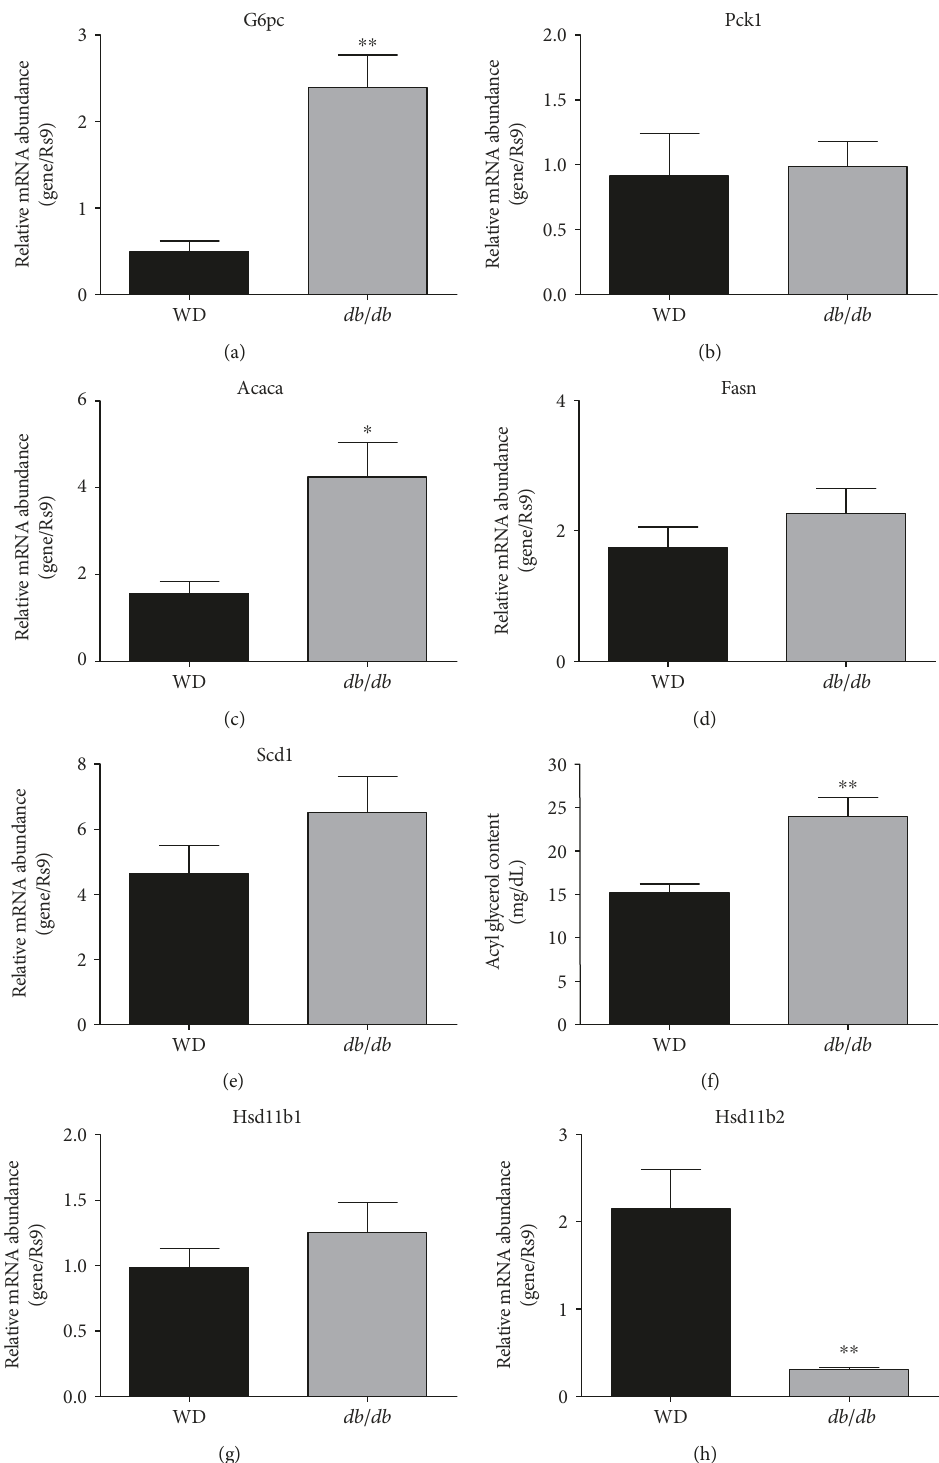
Figure 6: Livers from db/db mice displayed enhanced expression of glucose 6-phosphatase, acetyl Co-A carboxylase, and elevated acyl glycerol content when compared with livers from WD-fed mice. Relative mRNA abundance of the G6pc (a), Pck1 (b), Acaca (c), Fasn (d), Scd1 (e), Hsd11b1 (g), and Hsd11b2 (h) genes in the liver tissue from either C57BL/6J mice fed either Western diet for 20 weeks (black panels) or 14-week-old db/db mice (gray panels). Acyl glycerol content (f) was quanti fi ed using 30mg of liver tissue from either Western diet-fed C57BL/6J mice (20 weeks on diet; black panels) or 14-week-old db/db mice (gray panels). n = 8 per group. Data are represented as means ± SEM. ∗∗ p < 0 01 ; ∗ p < 0 05